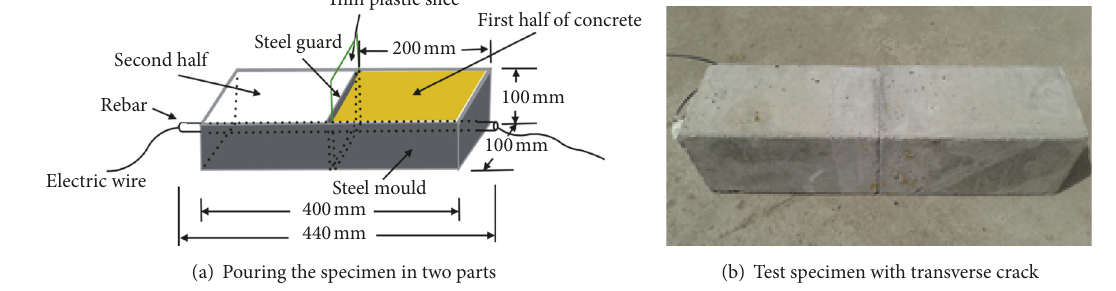
Figure 1: Schematic of the cracked concrete.